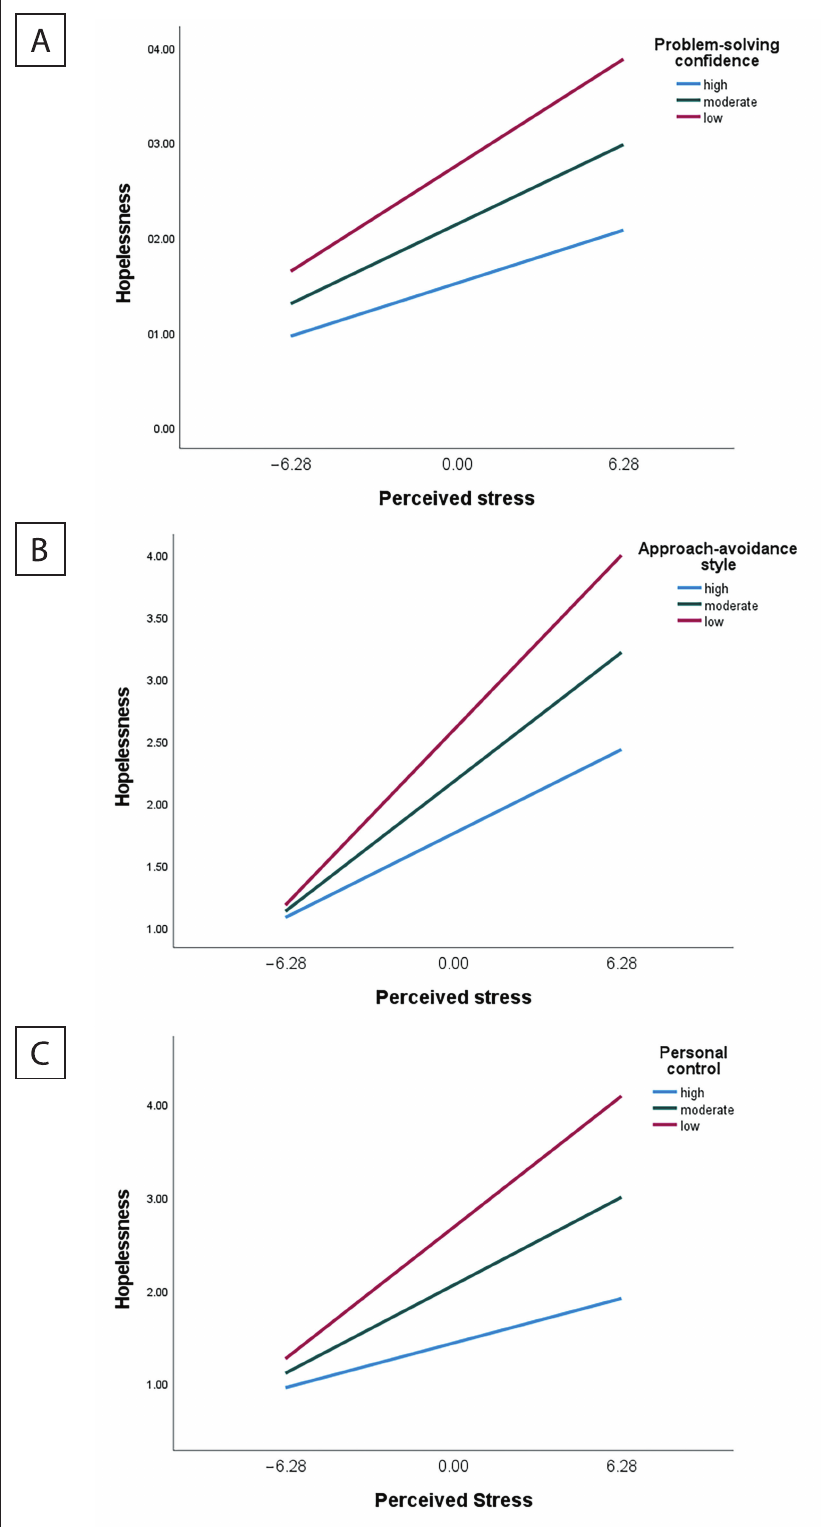
Figure 1. The relationship between perceived stress and hopelessness at different levels of the dimensions of problem-solving appraisals. ( A ) = problem-solving confidence, ( B ) = approach- avoidance style, ( C ) = personal